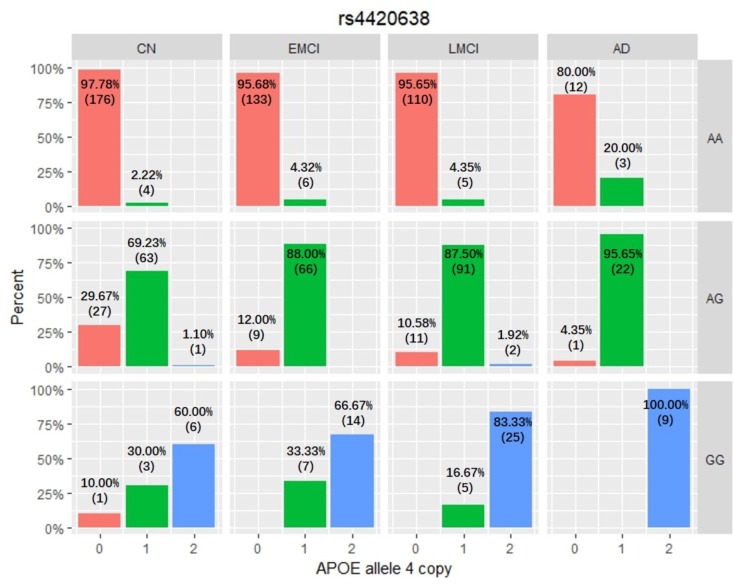
The relationship between APOE allele 4 copy numbers and rs4420638 alleles in four diagnostic groups.